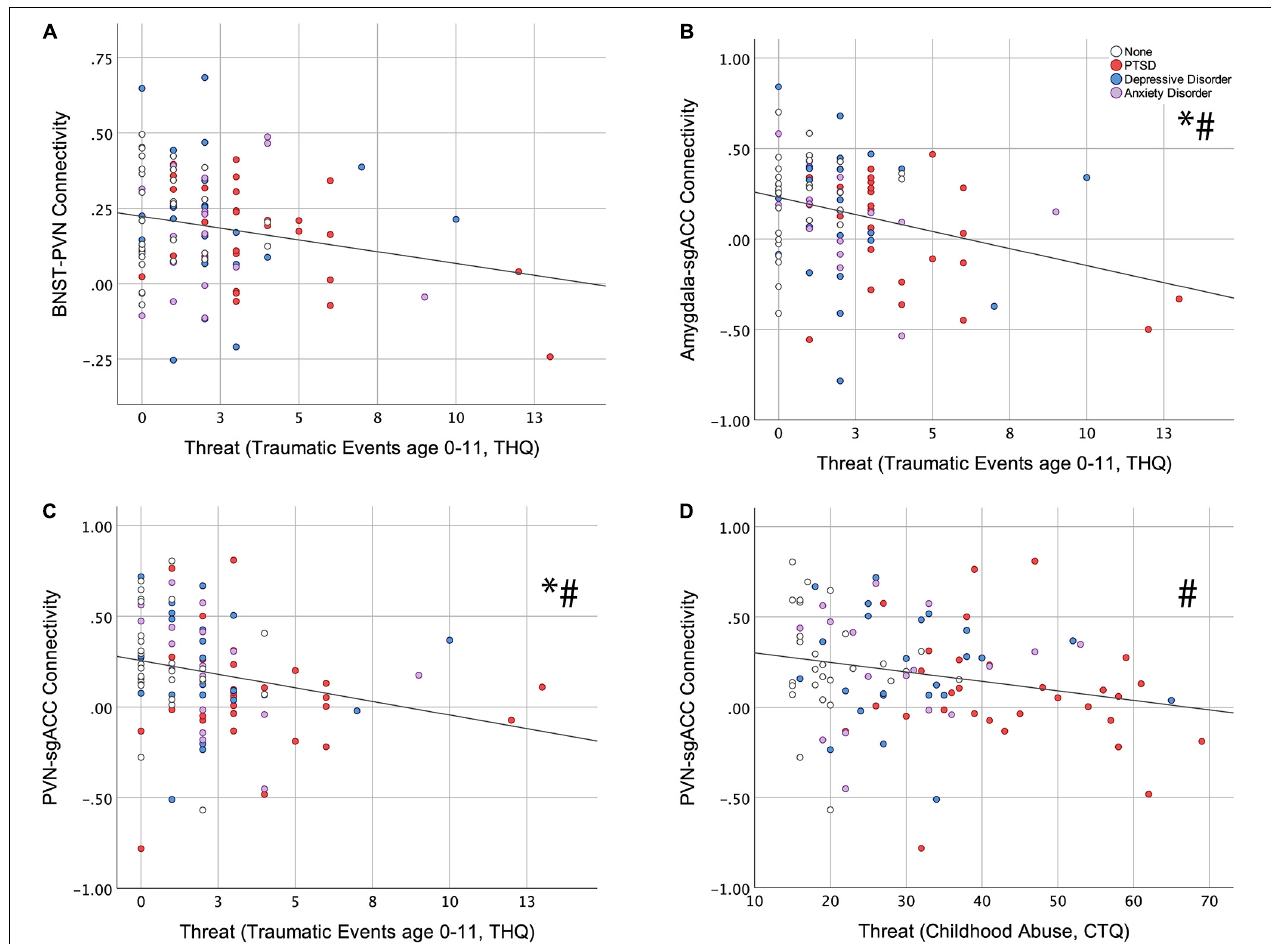
FIGURE 2 | Relationships between childhood threat and central visceral network resting-state connectivity. Hierarchical linear regression was used to examine associations between early traumatic events (Trauma History Questionnaire, THQ, age 0–11) and (A) BNST-PVN (ß = − 0.224; p = 0.033), (B) Amygdala-sgACC (ß = − 0.312; p = 0.003), and (C) PVN-sgACC (ß = − 0.264; p = 0.008) connectivity. (D) The association between childhood abuse (Childhood Trauma Questionnaire, CTQ) and PVN-sgACC (ß = − 0.258; p = 0.018) connectivity. * Indicates survival of FDR correction (0.05) for six tests; # indicates that the childhood threat variable remained significant with the addition of adulthood covariates (adulthood trauma, socioeconomic status and negative life events) to the model. (BNST, bed nucleus of the stria terminalis; PVN, paraventricular nucleus of the hypothalamus; sgACC, subgenual anterior cingulate